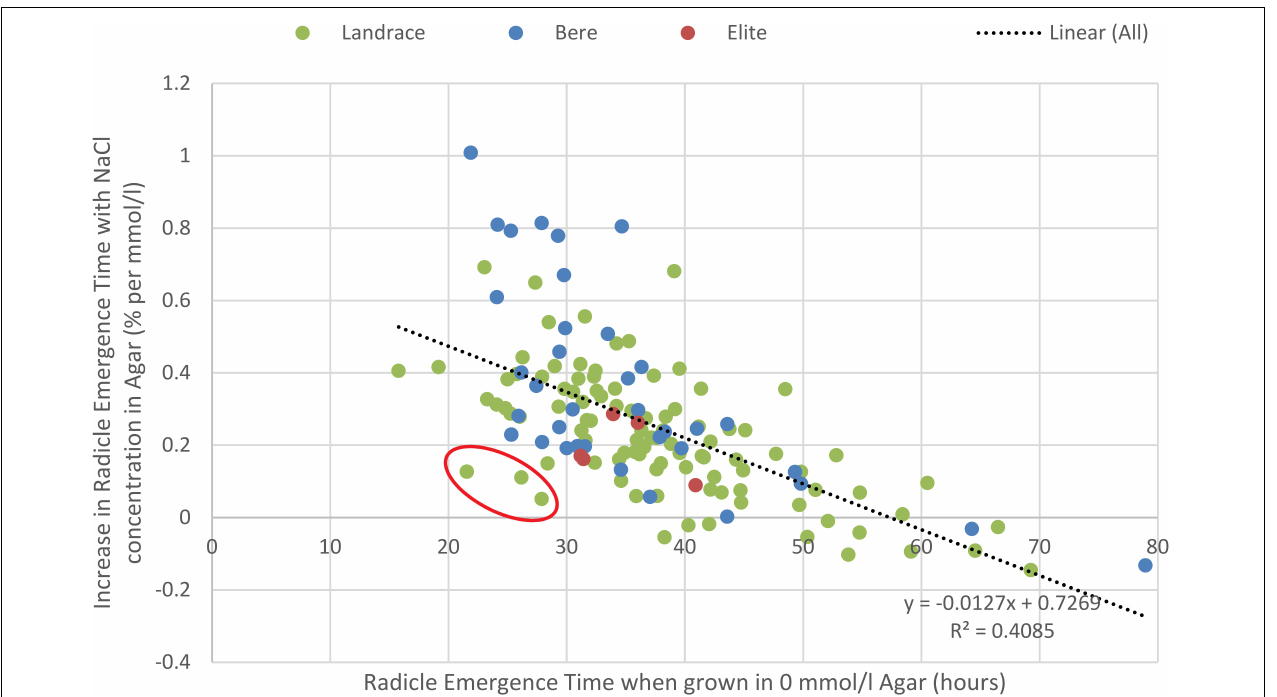
FIGURE 4 | Correlation between the delay in germination due to salinity (measure by percentage increase in radicle emergence time with increased salt concentrations) and the control germination rate of the experiment (measured as the radicle emergence time in control conditions). The line of best fit along with the coefficient of determination ( R 2 ) value is given; p < 0.001. Circled in red are Lawina, HSX07-26, and Nepal 92 BN-1, lines identified as both fast to germinate and able to maintain most of this speed with increasing salt concentrations.